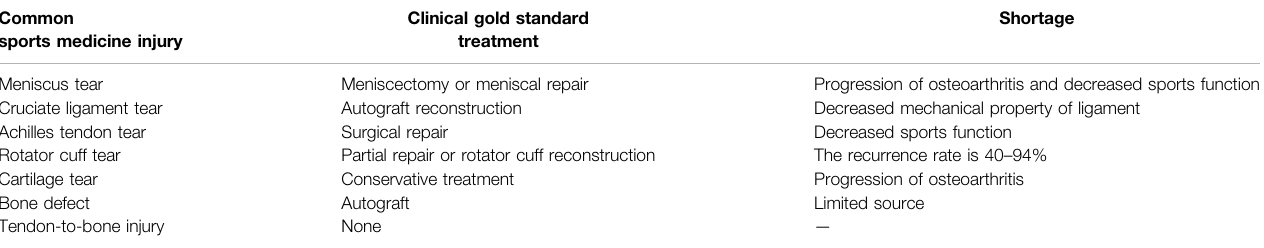
TABLE 1 | Common sports medicine injuries and their promising treatment methods.